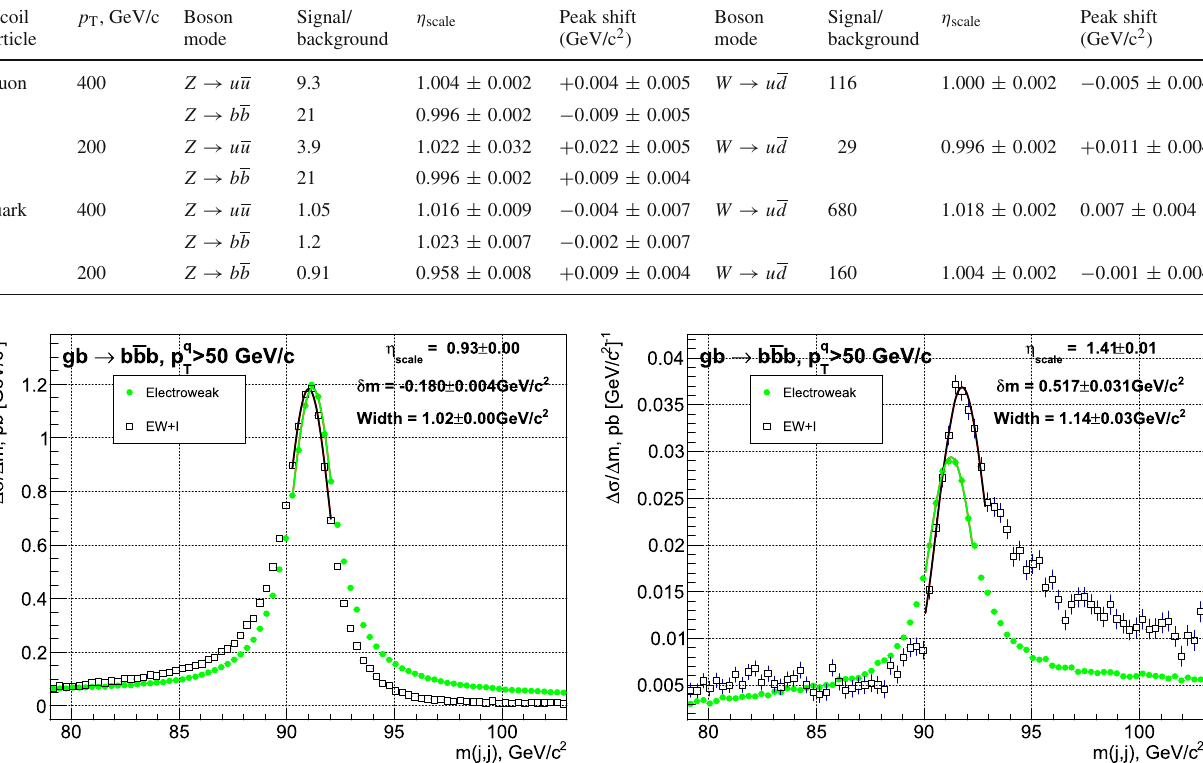
grams that produce a colour octet bb from gluon